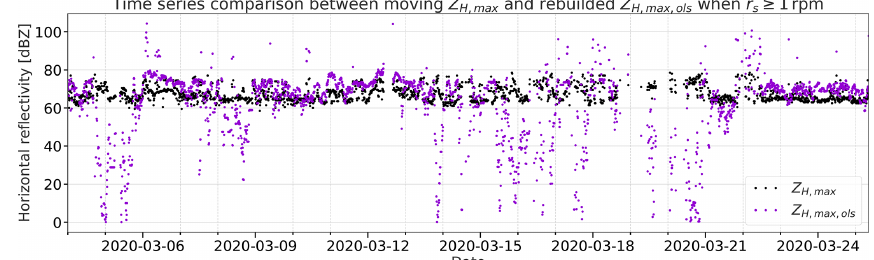
Figure 16. Time series scatterplots of the 10min moving maximum of Z H , max (black) and the corresponding OLS-model-based rebuilt maximum of the horizontal reflectivity Z H , max , ols (violet) when the rotor speed r s ≥ 1rpm. For the input of the model estimation, only the WT blade pitch angle θ and nacelle orientation (cid:57) are